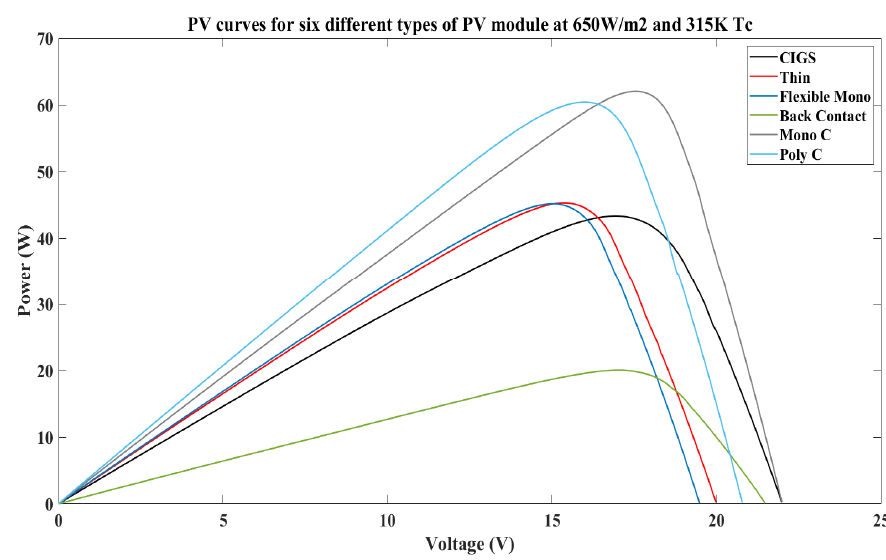
Figure 15. Predicted PV curves for the six PV modules at 650 W/m 2 and 315 K T c .